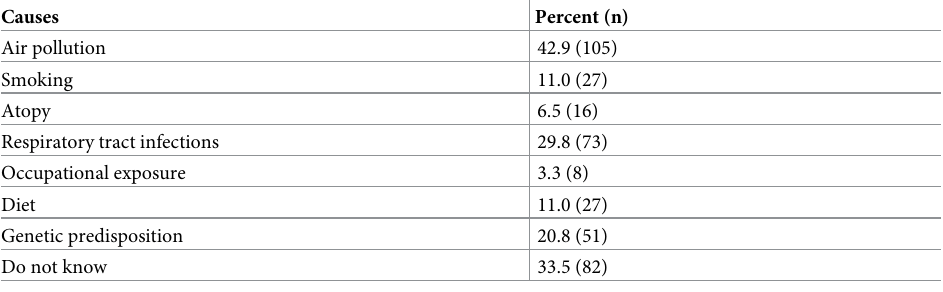
Table 5. Perceived causes of respiratory allergies in Qassim, KSA, September–December